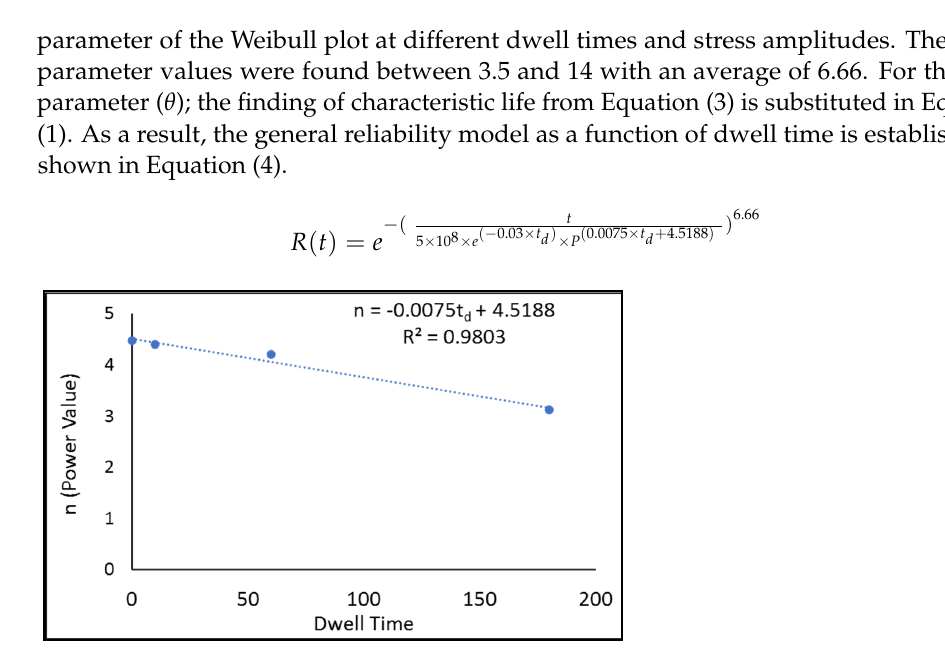
Figure 14. Power value ( n ) as a function of dwell time.